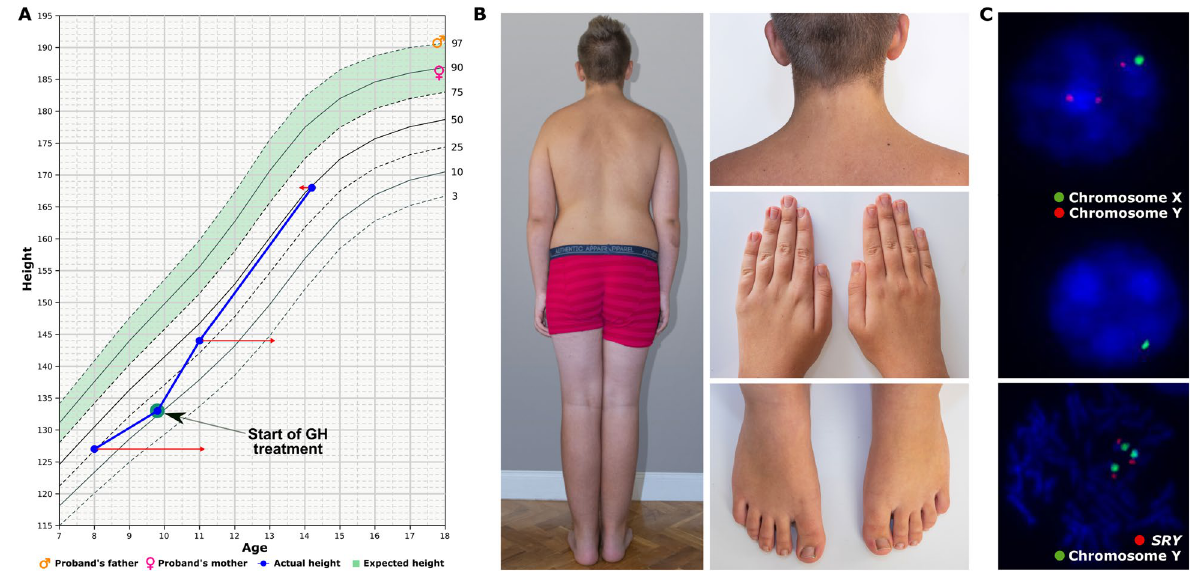
Figure 1. Clinical diagnostics overview. Panel ( A ) shows the proband’s growth chart over 6 years (blue line). 22 At 8 years of age, the proband’s height was 127 cm (25th percentile) with the standard deviation score (SDS) of -0.6. The individual’s mother and father height are at 90th and 97th percentiles, respectively, with mid parental height of + 1.8 SDS (the green zone presents the proband’s expected height range). Growth hormone (GH) therapy was implemented successfully two years later, resulting in the patient’s height increase to the 50th percentile at the time of the most recent follow-up at 14 years of age. The red arrows indicate the corresponding bone age at the time of follow-up visits. At 8 years of age the proband had significantly accelerated bone maturity (bone age corresponding to 11 years) with the gradual decrease to 13 years at the age of 11 and the bone age appropriate for chronological age at the time of the most recent follow-up at 14 years old. Panel ( B ) shows images of short wide neck with low “M-shaped” hairline and hypoplastic nails, clinical features characteristic for Turner syndrome (45, X). Other subtle dysmorphic features included low-set ears, buckle-shaped chest, widely spaced breast nipples and numerous pigmented marks (not shown). Panel ( C ) presents standard cytogenetics results of the proband’s peripheral blood lymphocytes by fluorescent in situ hybridization (FISH) analyses, resulting in the 45,X/48,XYYY karyotype confirmation, i.e. nuc ish(DXZ1 × 1)[55]/(DXZ11, DYZ × 3)[62], with the normal SRY locus. Details of cytogenetics results are described in the Supplementary